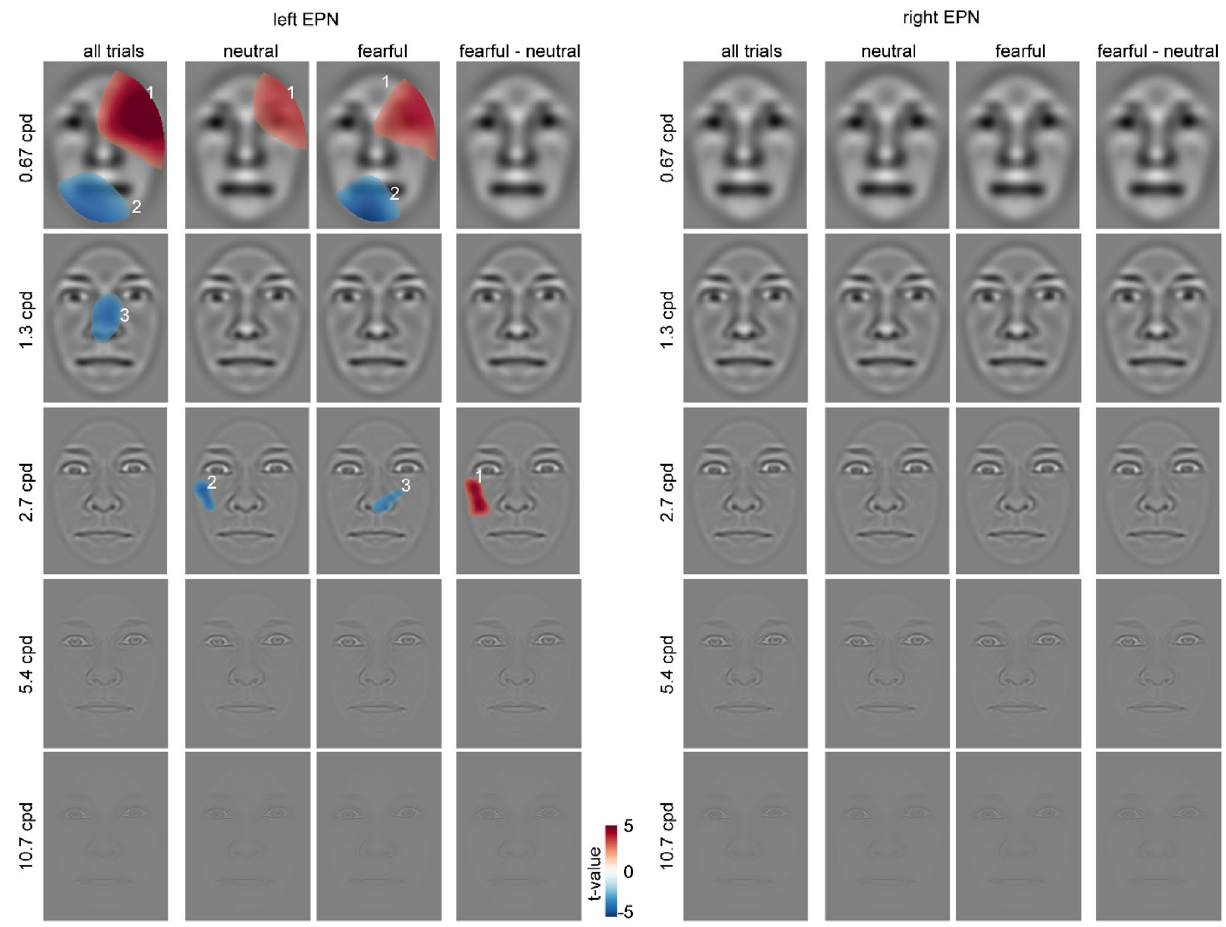
Figure 8. Classification images for the EPN component depicting face regions that contributed significantly to an amplitude increase (red) or decrease (blue). The clusters are enumerated to assign them to the respective statistics reported in the main text. Please note that the electrodes used for classification image calculations were chosen individually (see “Methods” section), whereas the ERP data in Fig. 7 are based on common sensors for